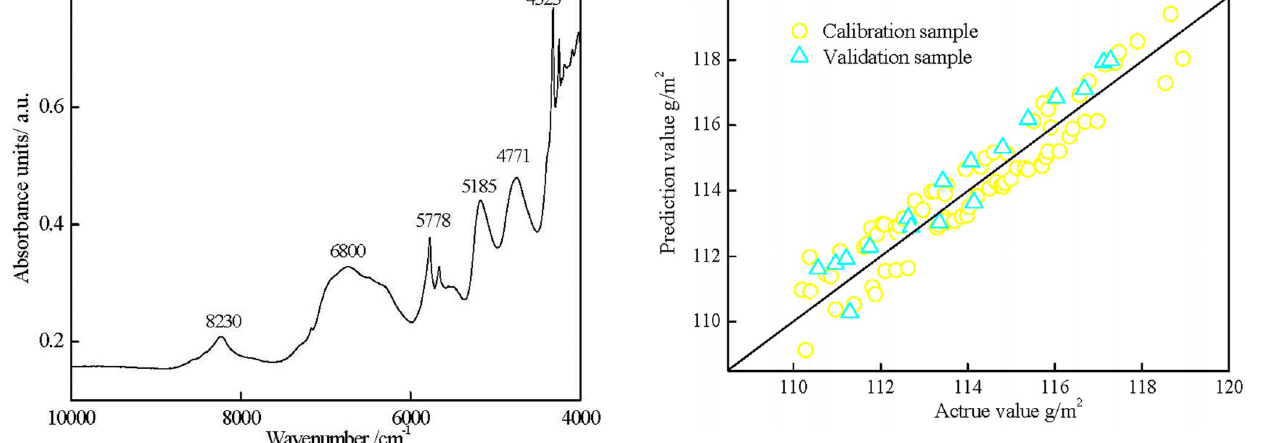
Figure 4. NIR diffuse reflectance spectral of RC-IJP.